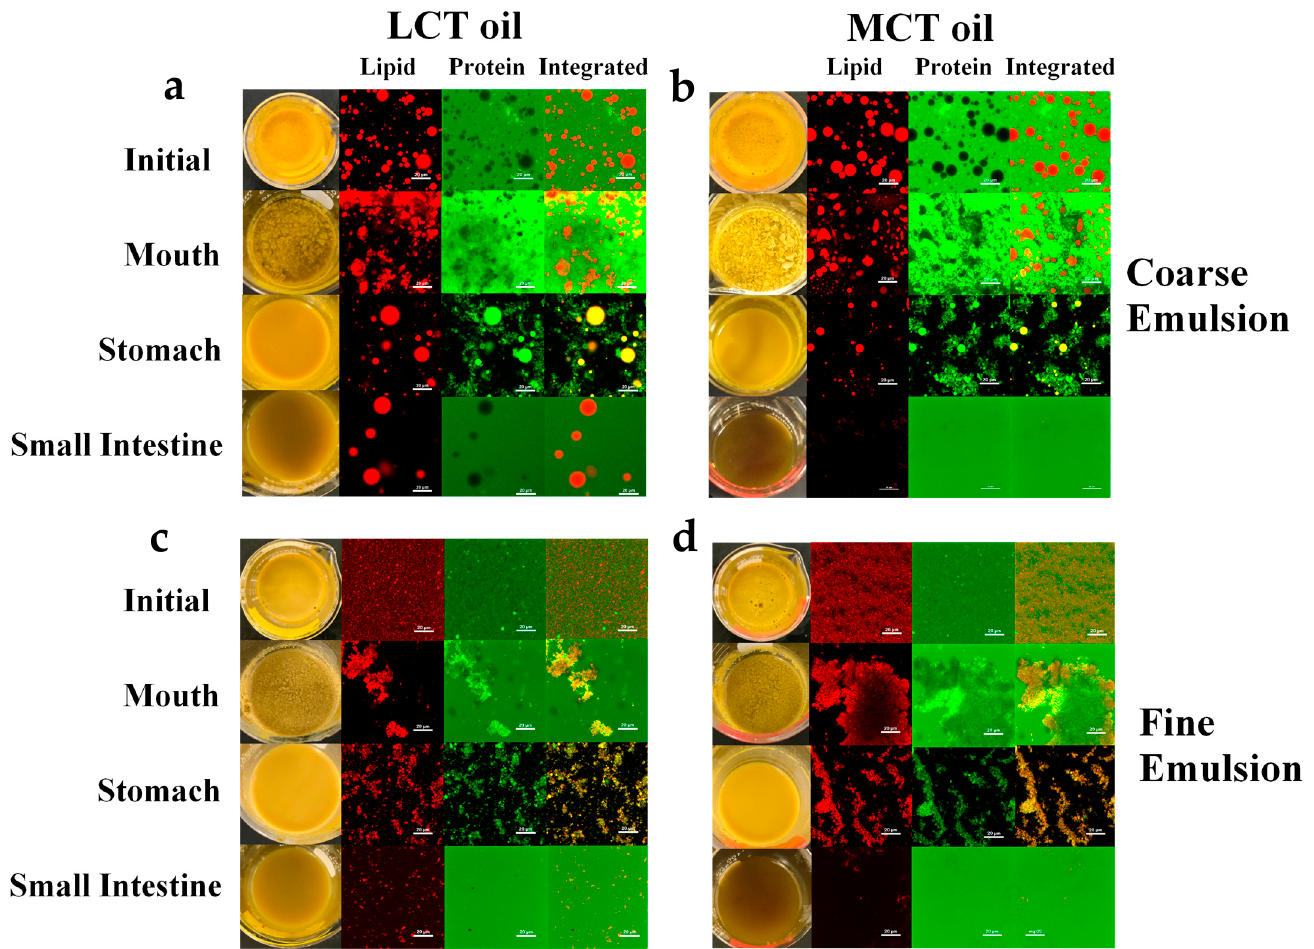
Figure 3. Impact of initial droplet size and oil type on the confocal fluorescence microscopy images of plant-based egg analogs after exposure to different stages of a simulated gastrointestinal tract. Lipid (red), protein (green), and integrated (both) images are presented. The white scale bars represent 20 µ m. Different egg analogs represented by different letters: Coarse/LCTs ( a ); Coarse/MCTs ( b ); Fine/LCTs ( c ); and Fine/MCTs ( d ). LCT: long chain triglycerides. MCT: medium chain triglycer- ides.